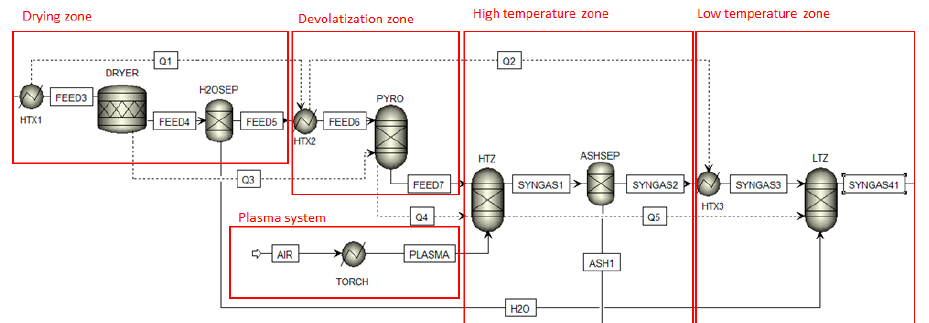
Figure 2. Waste pre-treatment unit.